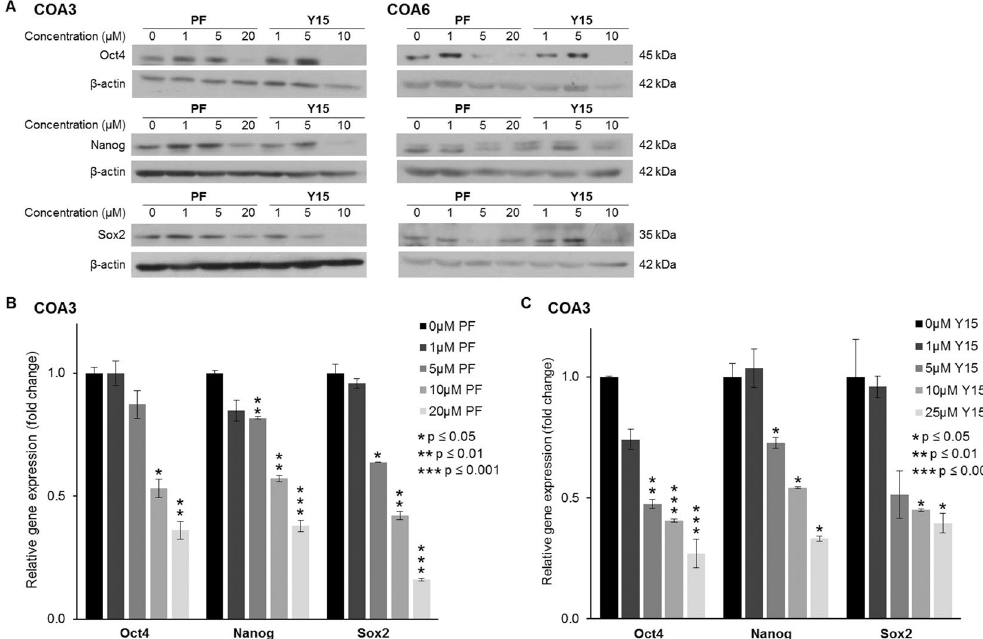
Figure 5. FAK inhibition decreased tumor cell stemness. ( A ) Immunoblotting of COA3 and COA6 cell lysates for markers of stemness including Oct4, Sox2, and nanog was performed. Treatment of cells with